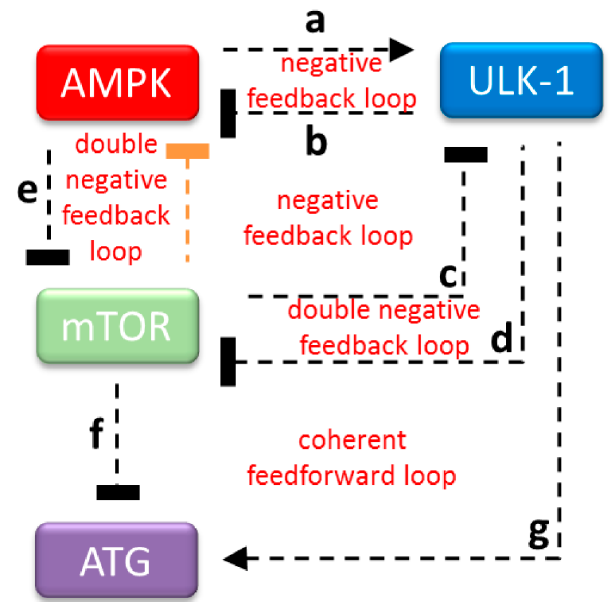
Figure 1. The wiring diagram of the AMPK–mTOR–ULK1 regulatory triangle controlled stress response mechanism. AMPK, mTOR, and ULK1 are denoted by isolated red, green and blue boxes, respectively. ATG (see purple box) refers to the autophagy activator complex. Dashed line shows how the components can influence each other, while blocked end lines denote inhibition. The feedback loop proven here both experimentally and theoretically is